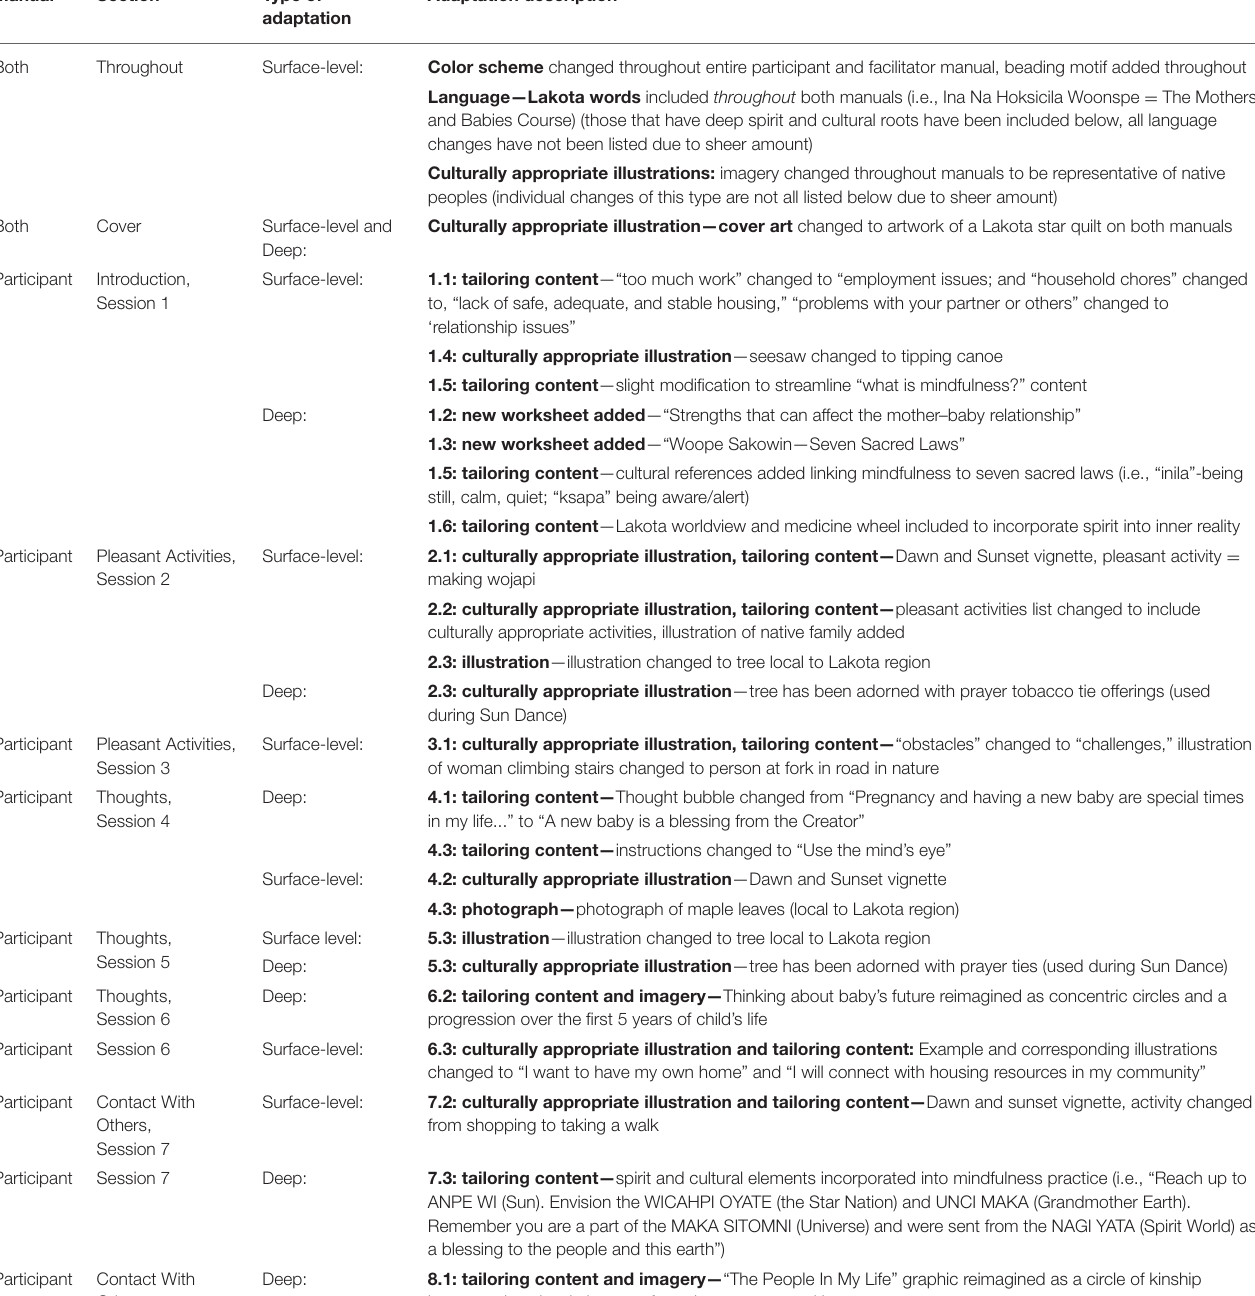
Adaptation description adaptation